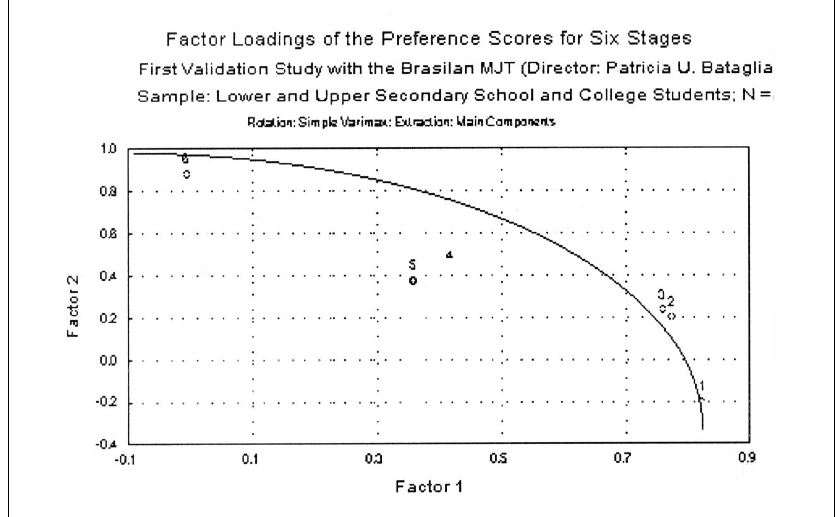
Figura 4 . Estrutura quase-simplex – Validação do MJT em 1998 (Lind, 2006)